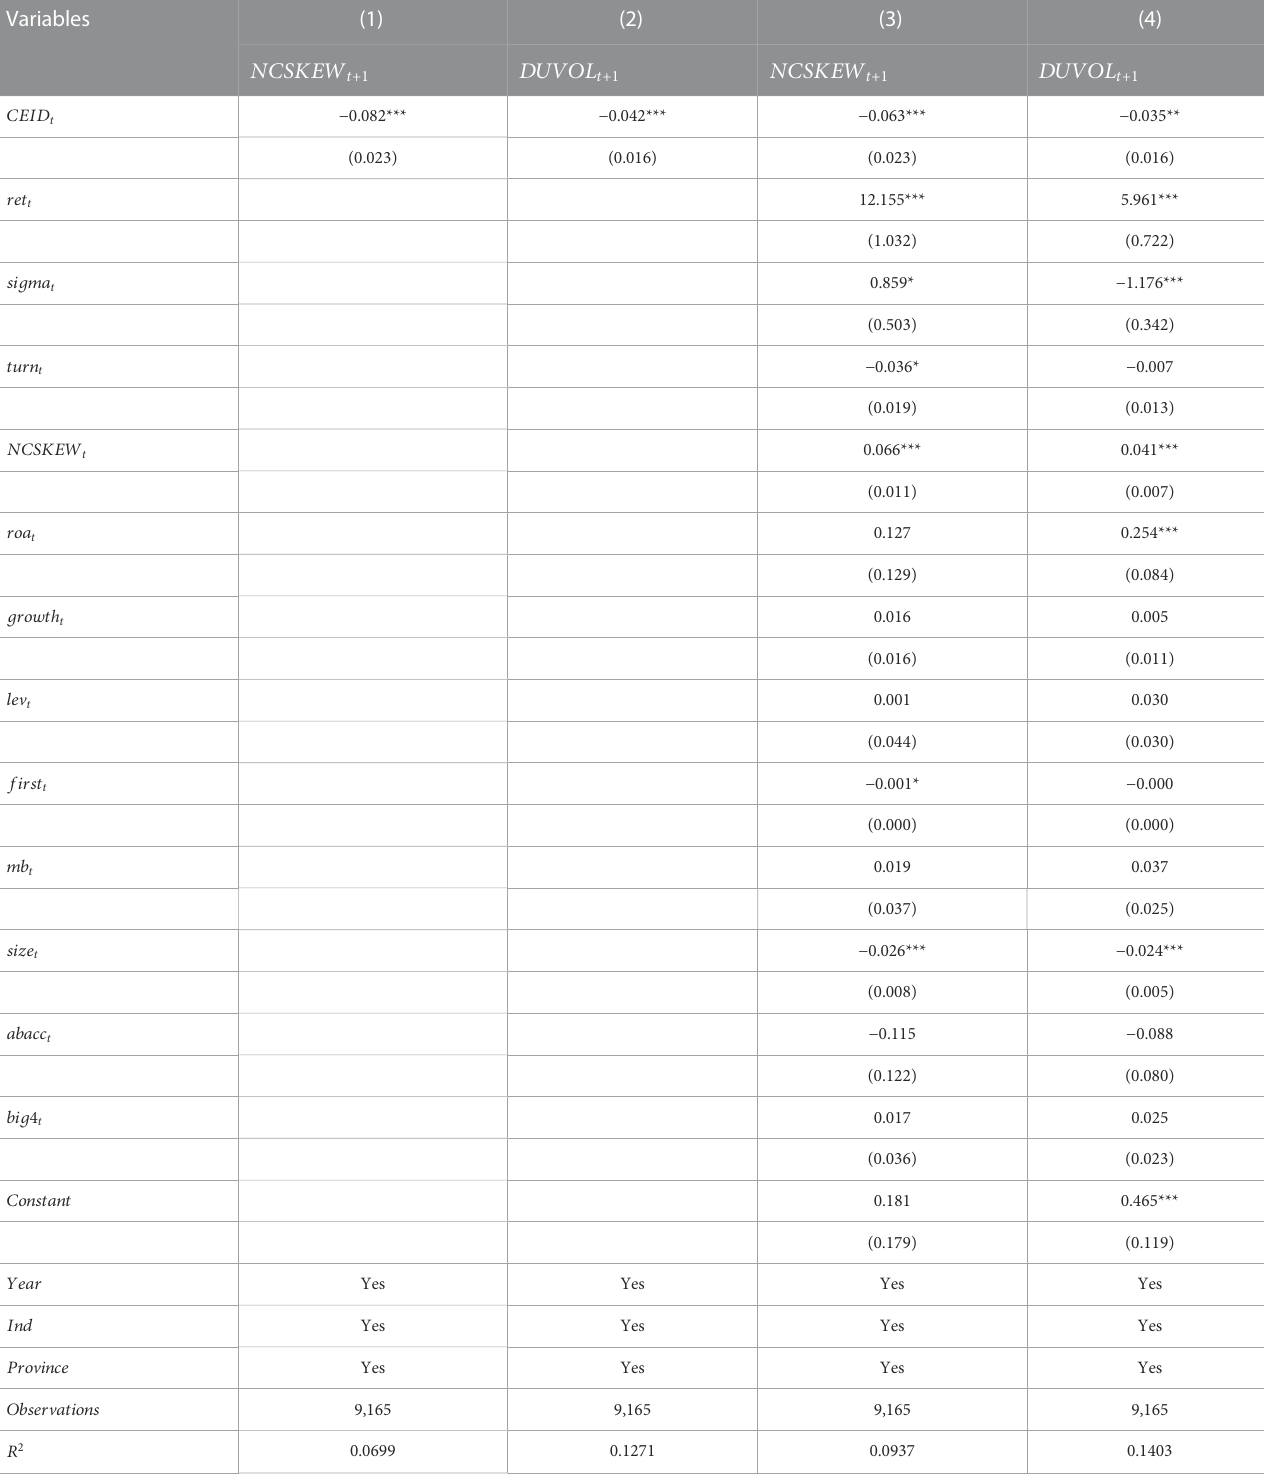
TABLE 3 Basic regression